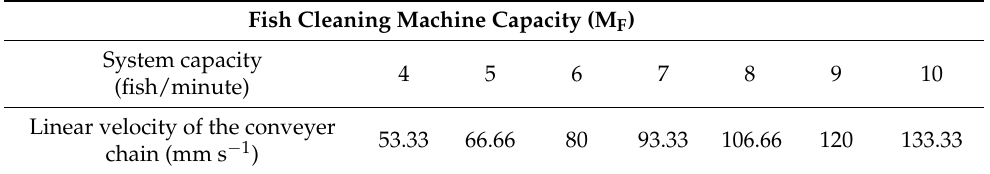
Table 1. The linear velocities in different system capacities.